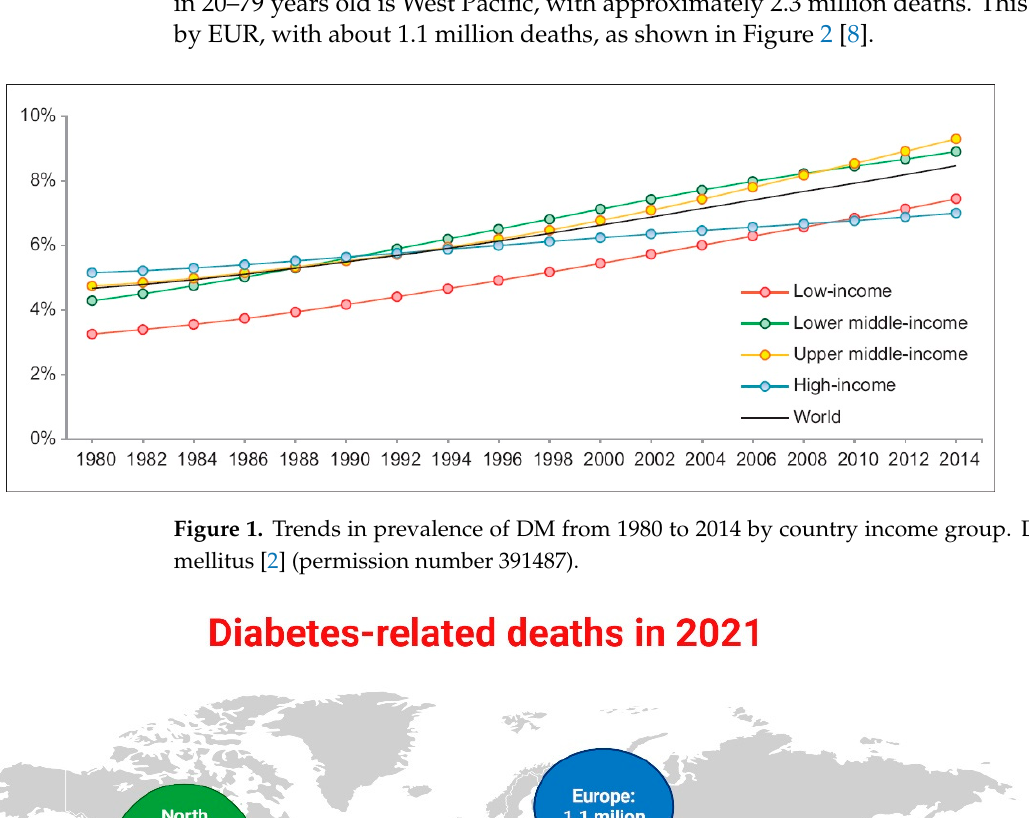
Figure 1. Trends in prevalence of DM from 1980 to 2014 by country income group. DM, diabetes mellitus [2] (permission number 391487).